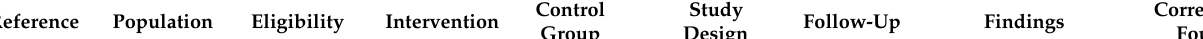
Table 4. Prospective studies of incident glaucoma or changes in intraocular pressure in patients with